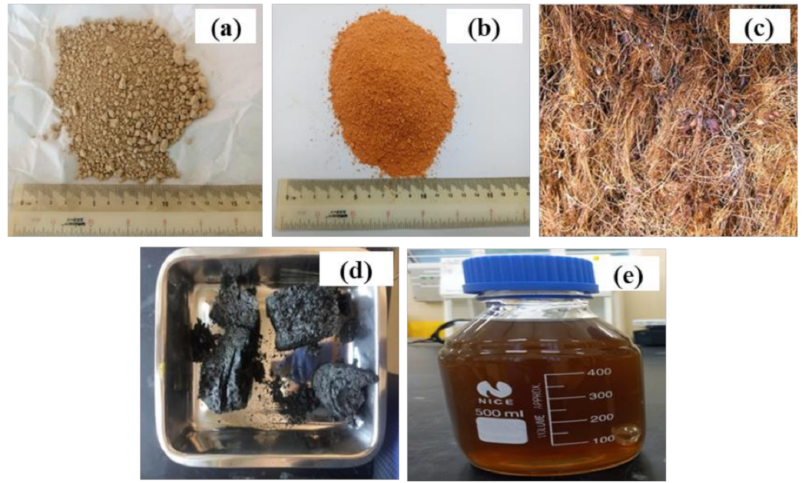
Figure 1. Pictorial view of ( a ) oven-dried alum sludge, ( b ) calcinated alum sludge, ( c ) mesocarp fiber, a ( d ) Alum sludge-based biochar, and ( e ) influent